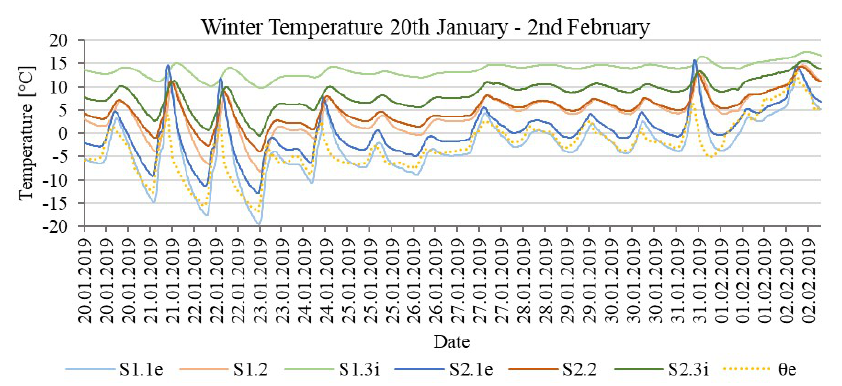
Figure 4. Comparison of the temperature in the winter period.